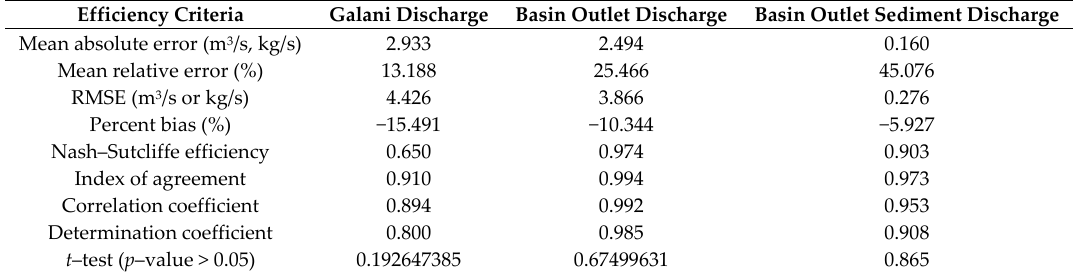
Table 1. Efficiency criteria values for the validation of water and sediment discharge.